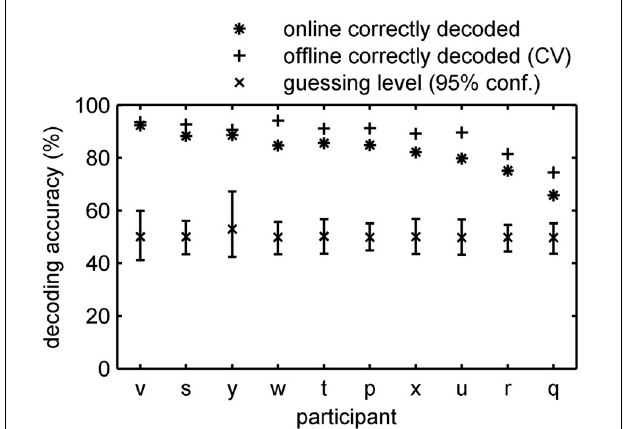
FIGURE 4 | Accuracy of online tracking. Single subject decoding accuracy obtained during the online decoding experiment with feedback. On average 82.8% (SE: 2.4%) of the time the content of the conscious percept was correctly decoded. An additional offline cross-validation procedure applied to the same data revealed 88.8% (SE: 1.9%) accuracy on average. Participants are sorted by